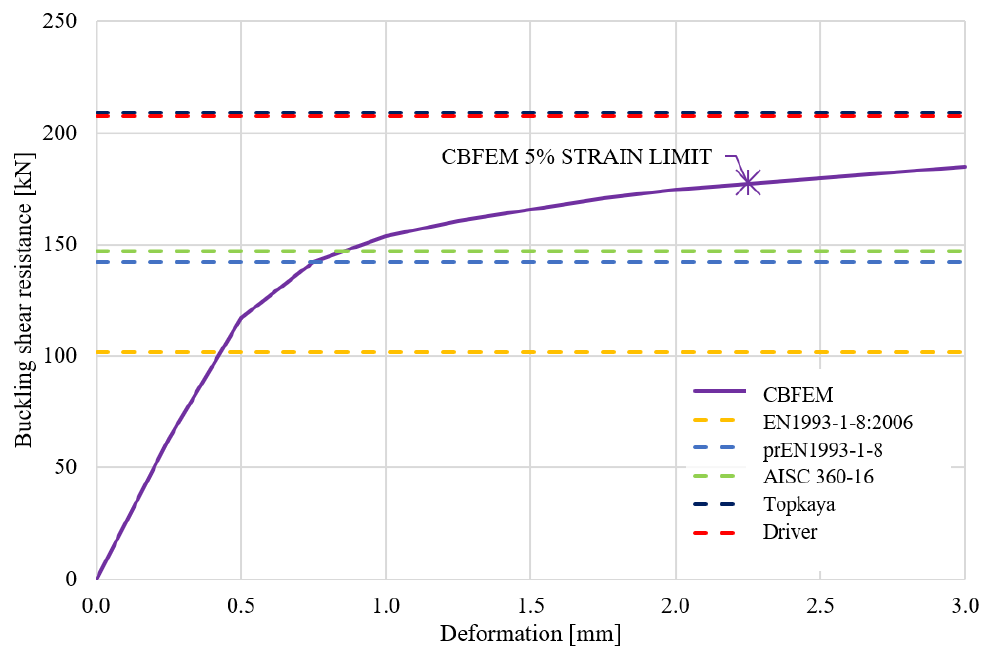
Figure 19. Load – deflection curve of eccentric bolted connection. Figure 19. Load–deflection curve of eccentric bolted